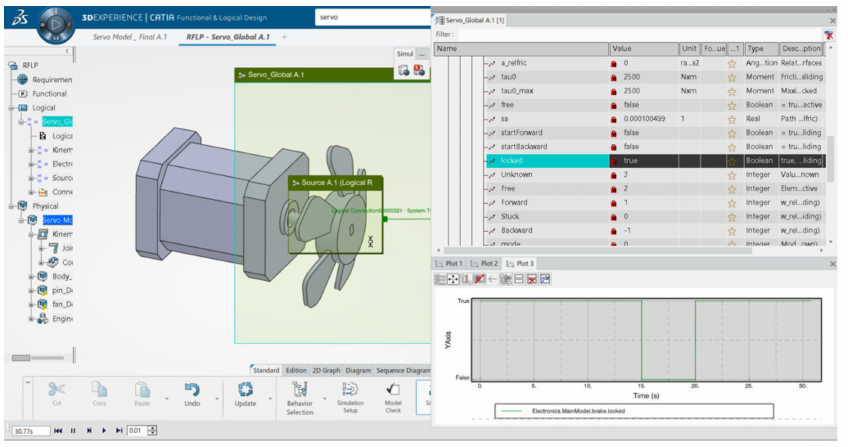
Figure 11. An example of 3DExperience simulation.